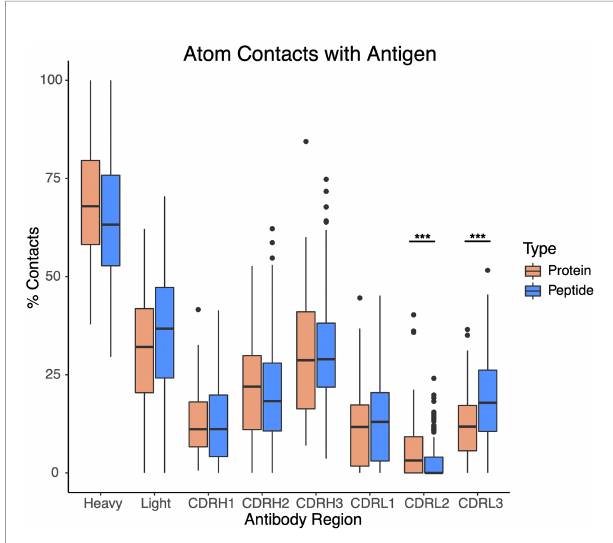
FIGURE 4 | Contacts with antibody heavy chain and CDR loops for sets of antibody-protein (N = 54) and antibody-peptide (N = 188) interfaces. All atomic-level contacts between antigenic protein or peptide and the antibody (< 4.5 Å) were counted for each antibody-protein and antibody-peptide interface, and percentages of atomic contacts within each interface including the heavy chain (Heavy), light chain (Light), and the six heavy and light chain CDR loops were calculated. Statistically signi fi cant differences between sets of antibody-protein and antibody-peptide values (Wilcoxon rank sum test) are indicated (***: p ≤